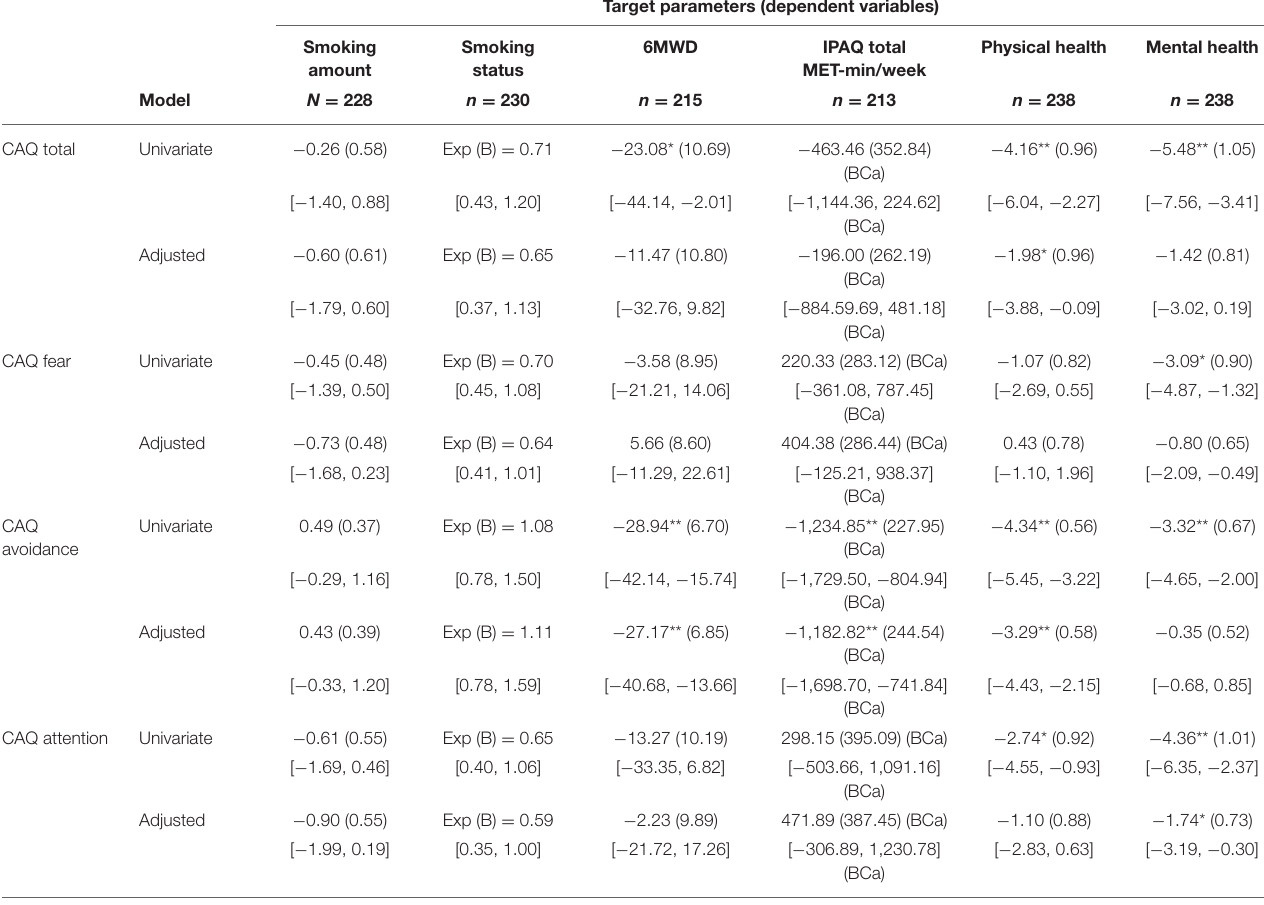
TABLE 3 | Regression coefficients of the CAQ scales predicting health behaviors at